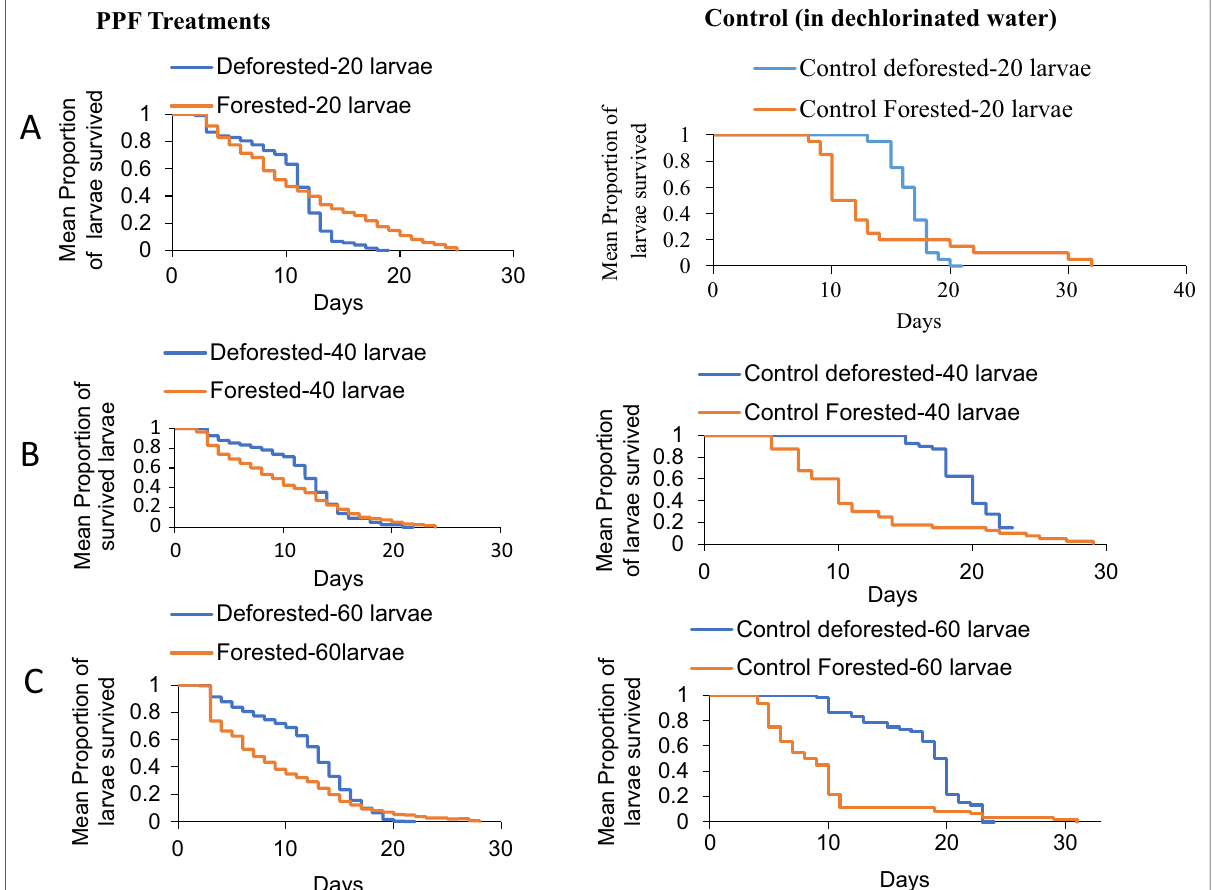
Fig. 6 The impact of pyriproxyfen at 0.03 ppm on An. gambiae s.s. larvae survival time in forested and deforested area at density of 20, 40 and 60 larvae ( A , B and C respectively). Experiments were done 6 times in 3